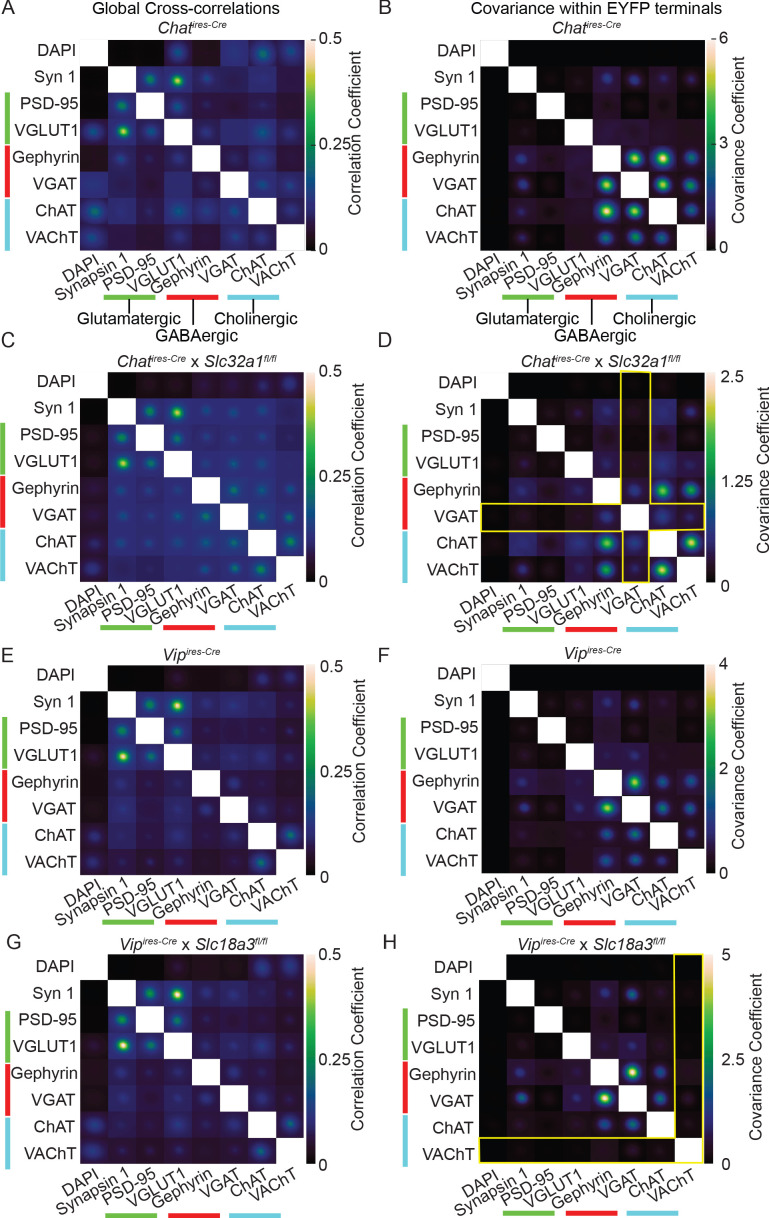
Average cross-correlations of synaptic antibody image arrays from Chatires-Cre, VGAT mosaic knock-out (Chatires-Cre x Slc32a1fl/fl), Vipires-Cre, and VAChT mosaic knockout mice (Vipires-Cre x Slc18a3fl/fl).(A,B) Global cross-correlations (A) and co-variances within YFP masks of VIP+/ChAT+ pre-synaptic terminals (B) of tissue collected from Chatires-Cre mice injected with AAV(8)-DIO-Synaptophysin-YFP. These graphs are duplicated from Figure 2D & E. (C,D) To test the specificity of the VGAT antibody for VIP+/ChAT+ terminals, we repeated the analysis from Figure 2 in tissue from Chatires-Cre x Slc32a1fl/fl mice, and found that VGAT staining is no longer correlated with Gephyrin or the cholinergic markers ChAT and VAChT. Yellow bars in (D) highlight the loss of VGAT correlations within VIP+/ChAT+ terminals compared to (B). (E,F) To confirm the specificity of VAChT staining, we selectively deleted VAChT in VIP+ interneurons (Vipires-Cre x Slc18a3fl/fl). We therefore first tested the global cross-correlations and YFP-masked co-variances of tissue collected from Vipires-Cre mice injected with AAV(8)-DIO-Synptophysin-YFP, and saw similar patterns of enrichment for GABAergic and Cholinergic markers as in (B). (G,H) In contrast to tissue from Vipires-Cre mice, global cross-correlations and YFP-masked co-variances of tissue collected from mice with VAChT deleted from all VIP+ interneurons (Vipires-Cre x Slc18a3fl/fl) show that VAChT is no longer correlated with ChAT or GABAergic markers. Yellow bars in (H) highlight the loss of VAChT correlations within cortical VIP+ terminals compared to (F). Total number of image stacks and mice are the same as in Figure 4.